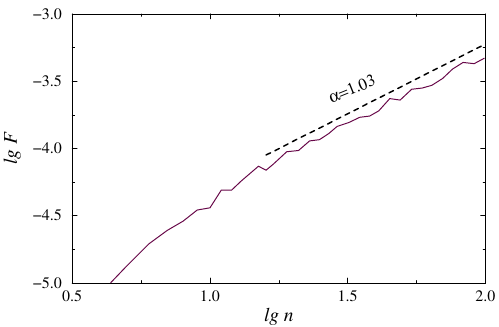
Figure 1. An example of F ( n ) dependence in the double logarithmic plot for an EEG signal. At step 3, a piecewise linear fitting is typically applied as the simplest and most universal approach, but the method has no restrictions with respect to other types of fitting. The α exponent quantifies anti-correlations in the signal x ( i ) , when small and large values tend to alternate ( α < 1/2), uncorrelated behavior ( α = 1/2), positive power-law correlations (1/2 < α < 1), positive